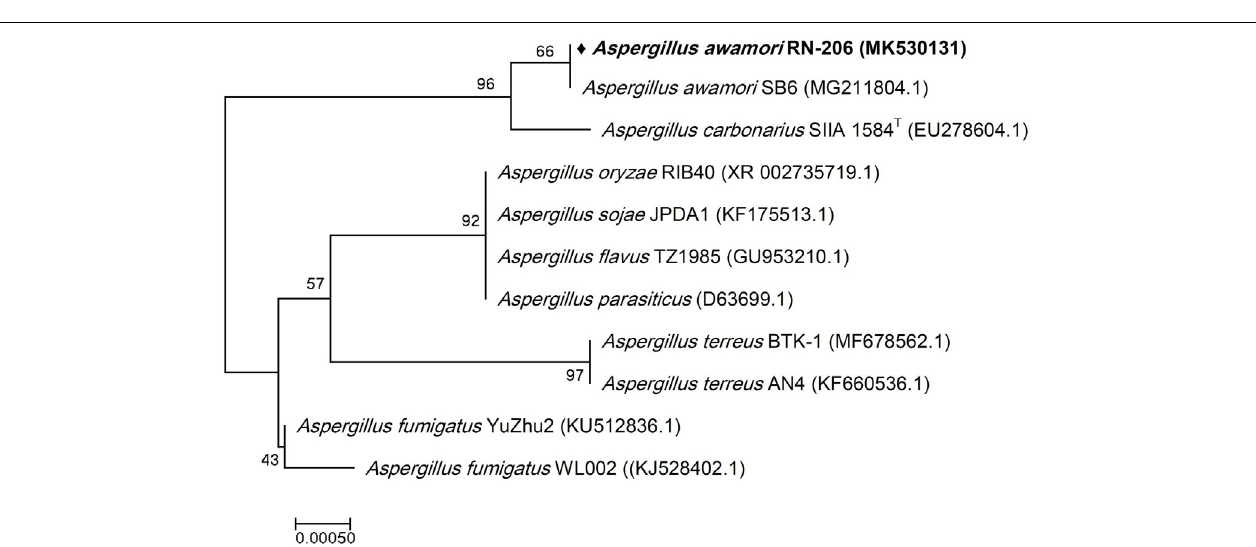
Frontiers in Microbiology |